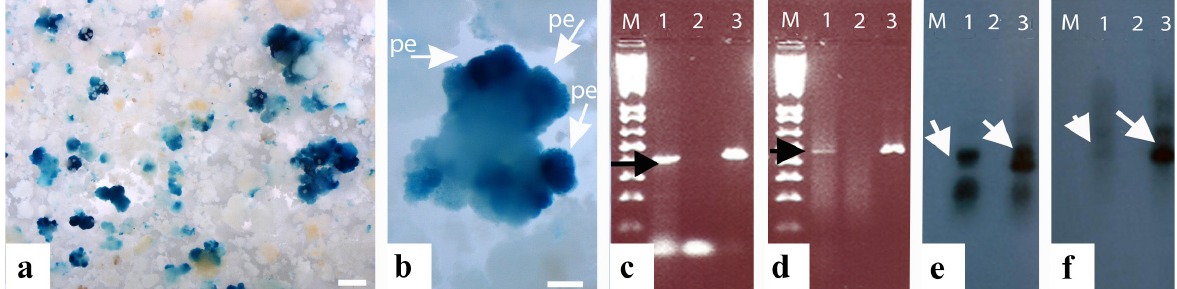
Figure 3 - Cell suspension of Brachiaria brizantha transformed by biolistic and molecular analysis of putative transformants. ( a- b ) cell suspension obtained in NBBAP (pH 4) after bombardment with pGPro1pUbi1; ( a ) stable gus expression in embryogenic calluses after cultivation for 10 m in regeneration medium (RM) in the presence of hygromycin (20 mg/L); ( b ) detail of ( a ) with proembryos expressing gus ; ( c - d ) detection of gus ( c ) and hptII ( d ) by PCR: column 1, DNA from hygromycin resistant calluses (arrows), column 2 negative control (water), column 3 plasmid pGPro1pUbi1 used as positive control; ( e-f ) PCR DNA gel blot hybridized with a gus probe ( e , arrows) and with hptII probe ( f , arrows). M, molecular weight marker (1 kb). pe = proembryos. Bars: ( a ) 1 cm; ( b ) 0.2 cm.